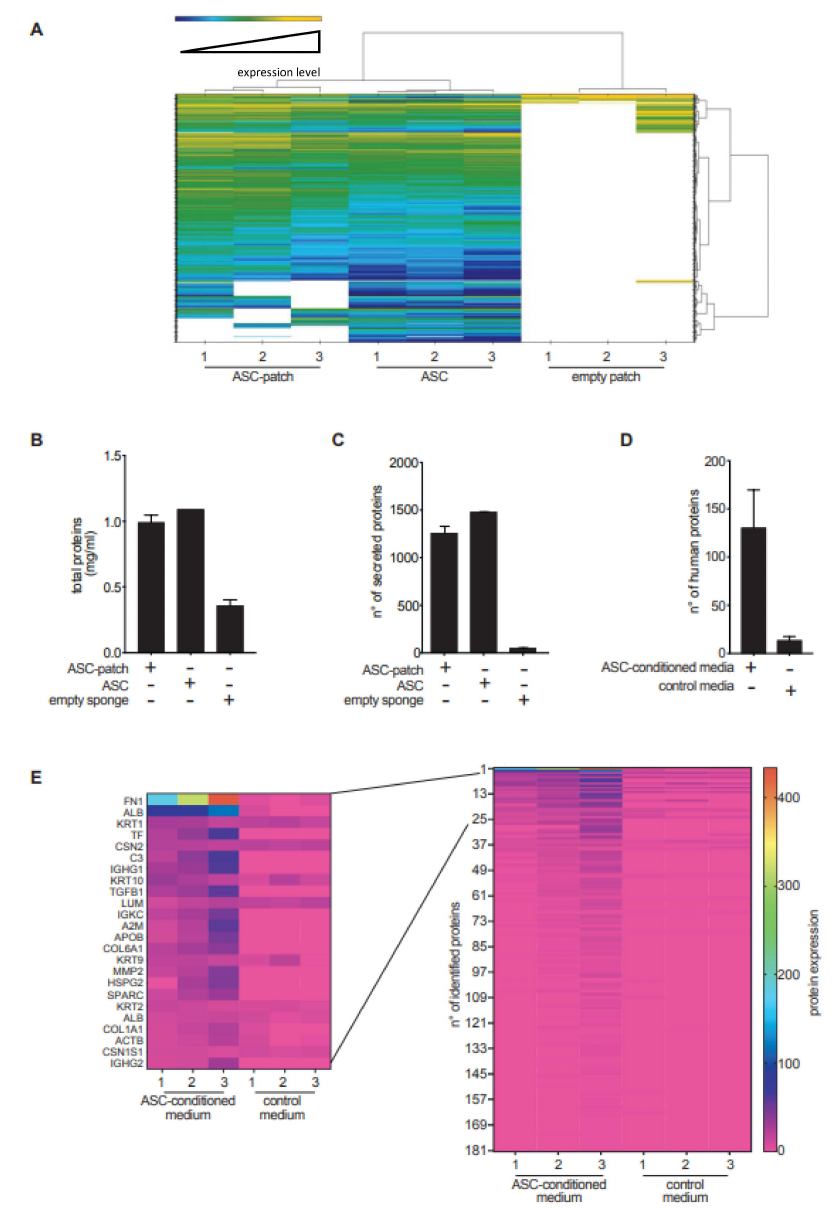
Figure 3. The ASC-patch concentrate of the ASC secretome and gelatin-derived products. ( A – C ) ASC- patches, ASC monolayer or empty gelatin sponge were incubated in a serum-free medium prior to a mass spectrometry analysis of the released proteome. ASC from three independent donors were analyzed. Hierarchical clustering analysis ( A ), total protein concentration ( B ) and total number of proteins identified ( C ) in each condition are shown. ( D , E ) An empty gelatin sponge was pre-incubated with serum-free media preconditioned or not with ASC. After enzymatic digestion of the gelatin sponge, a proteomic analysis was performed by mass spectrometry. ( C ) Total number of proteins identified by mass spectrometry in each condition. ( D ) Heatmap showing the relative quantification of the proteins as shown in C, with a zoom on the top-25 most abundant. Overall, in the figure, bars refer to mean ±